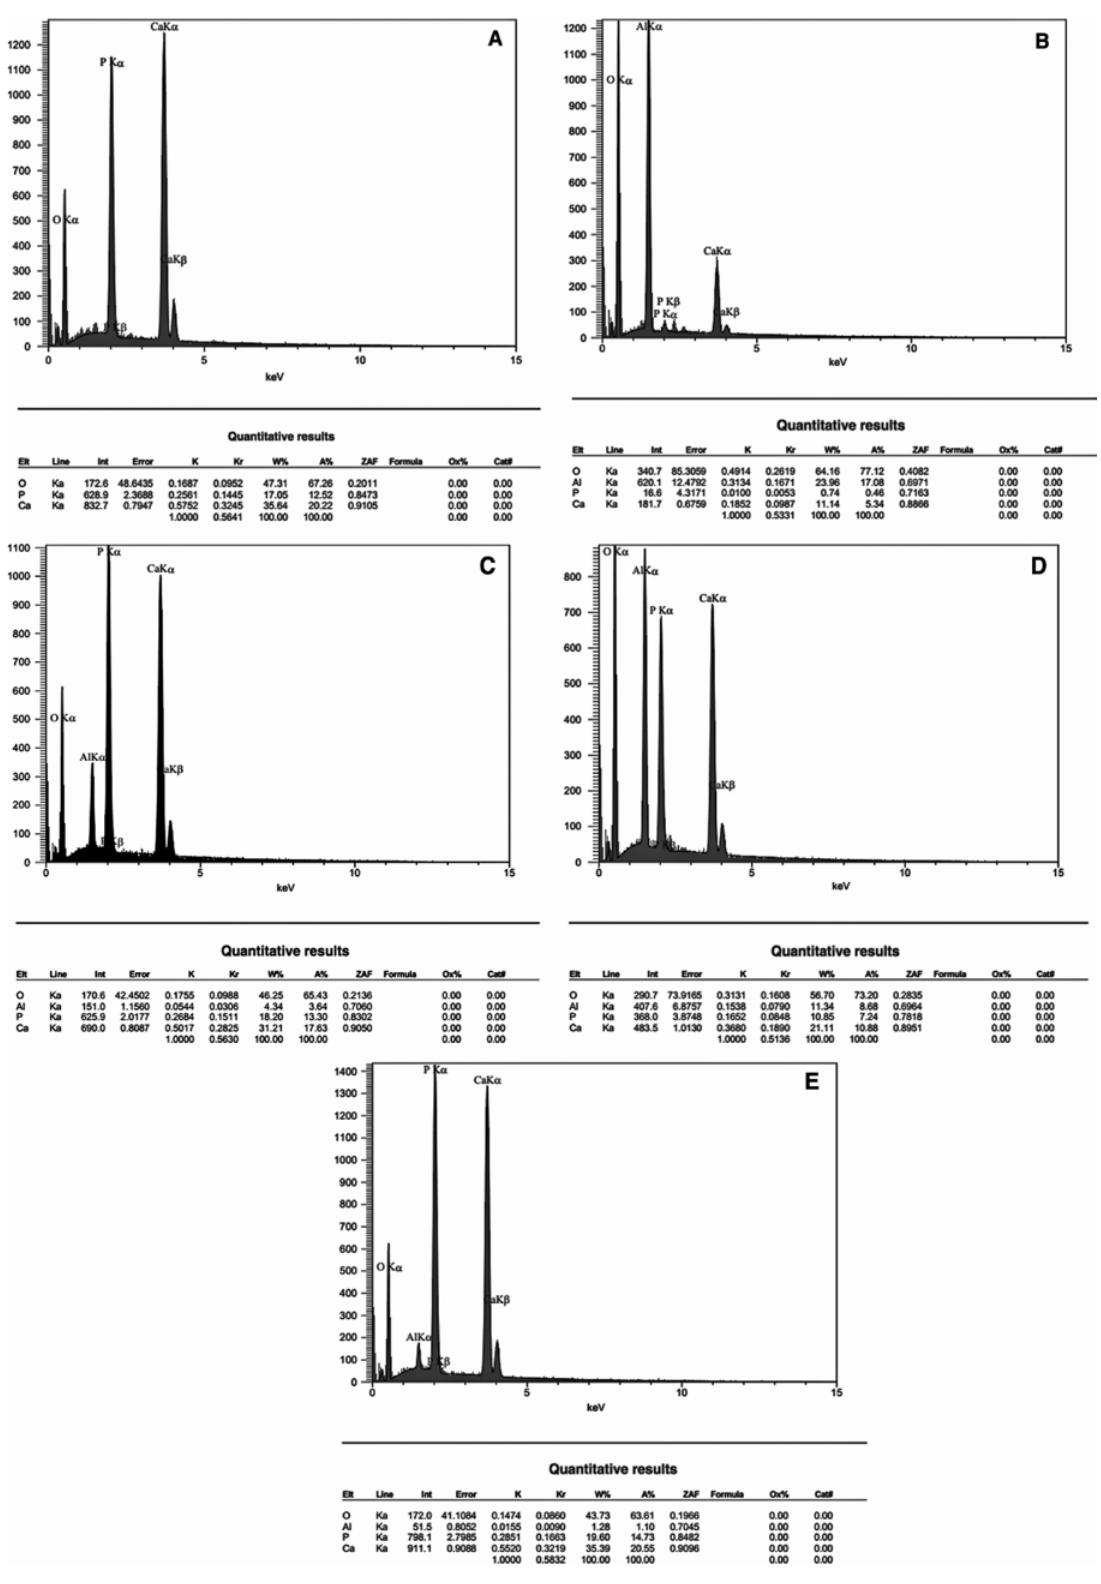
Figure 5: EDX spectra of samples after immersion in SBF. (A) HA, (B) CA, (C) nanocomposites synthesized by method 1, (D) nanocomposites synthesized by method 2, (E) nanocomposites